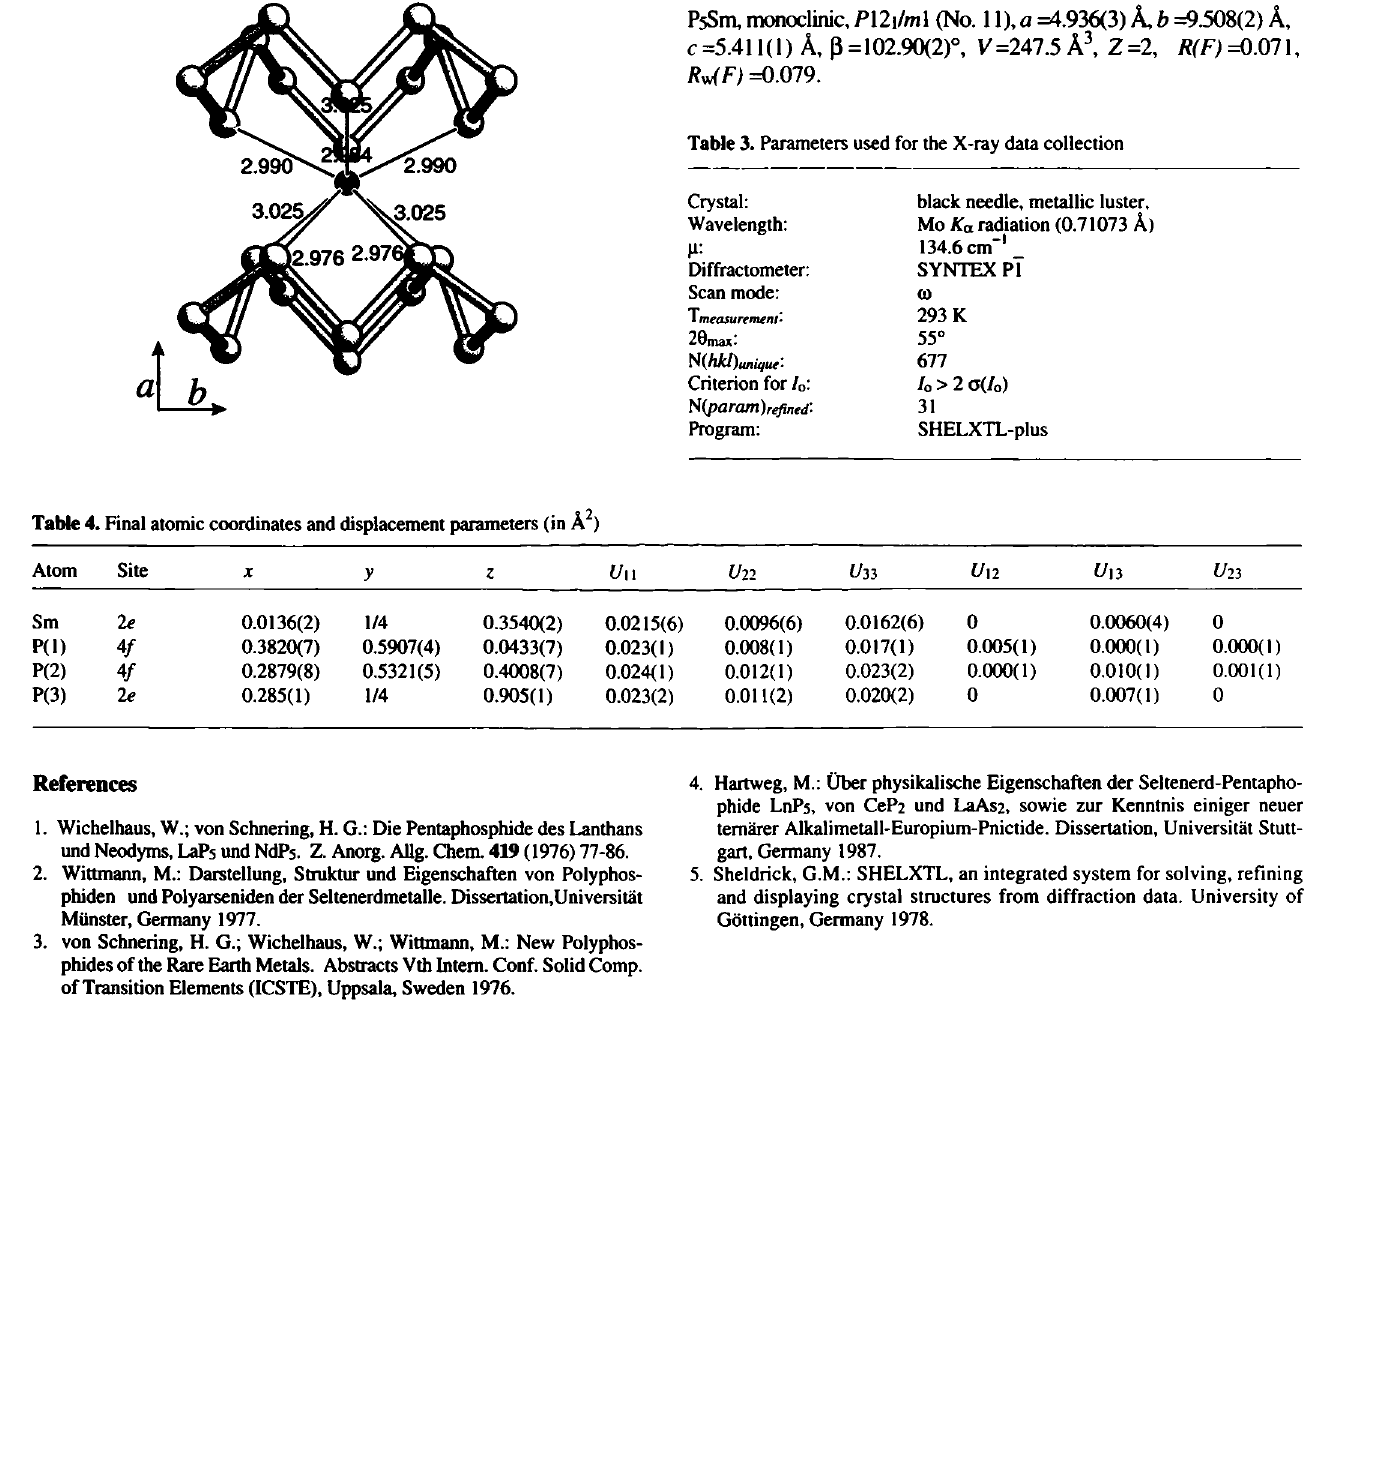
Table 3. Parameters used for the X-ray data collection Crystal: black needle, metallic luster. Wavelength: